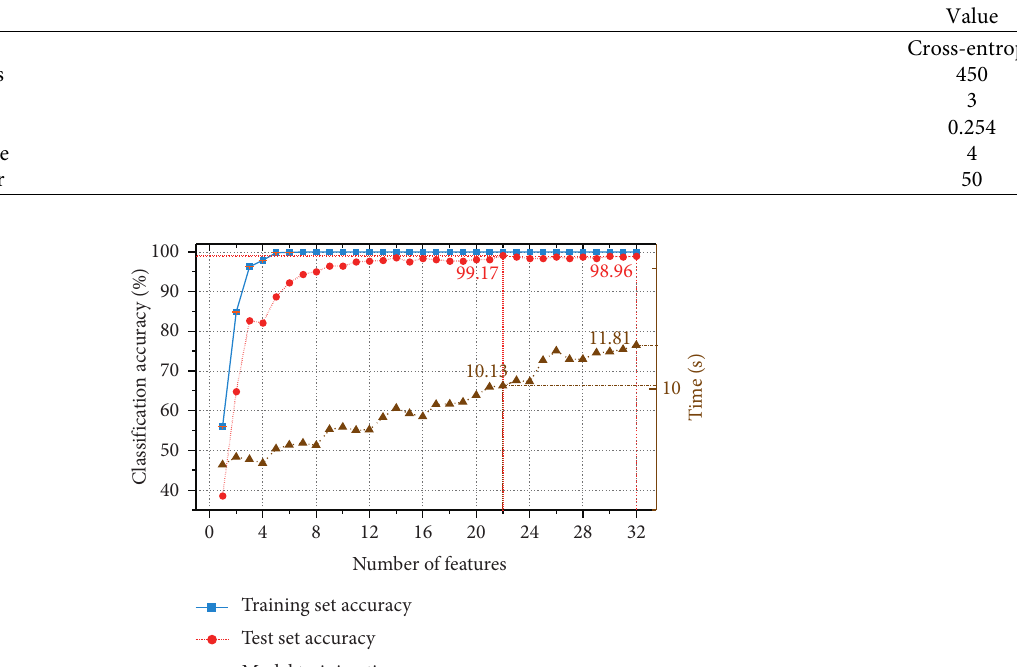
Table 5: The main hyperparameters of CatBoost optimized by BO